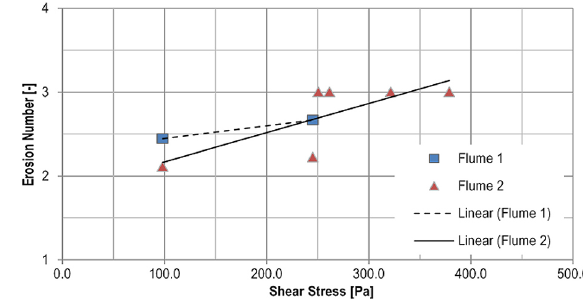
Fig. 12. Erosion numbers flumes 1 & 2 (vegetated); steep trend line = high erosion rate, Sept 2014